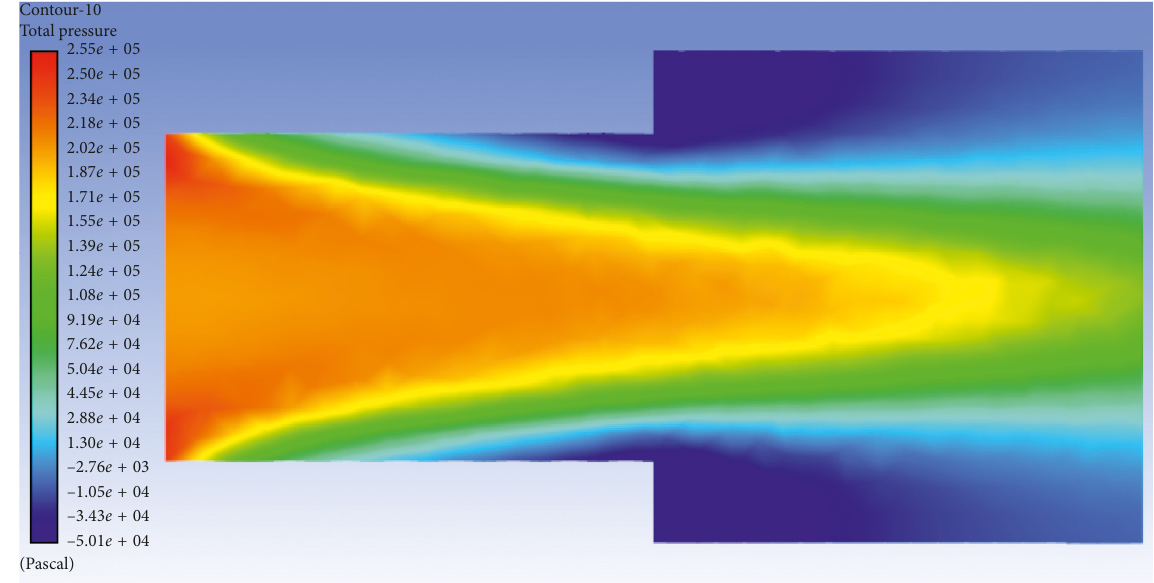
Figure 13: Pressure nephogram (sudden expansion ratio is 1.5).